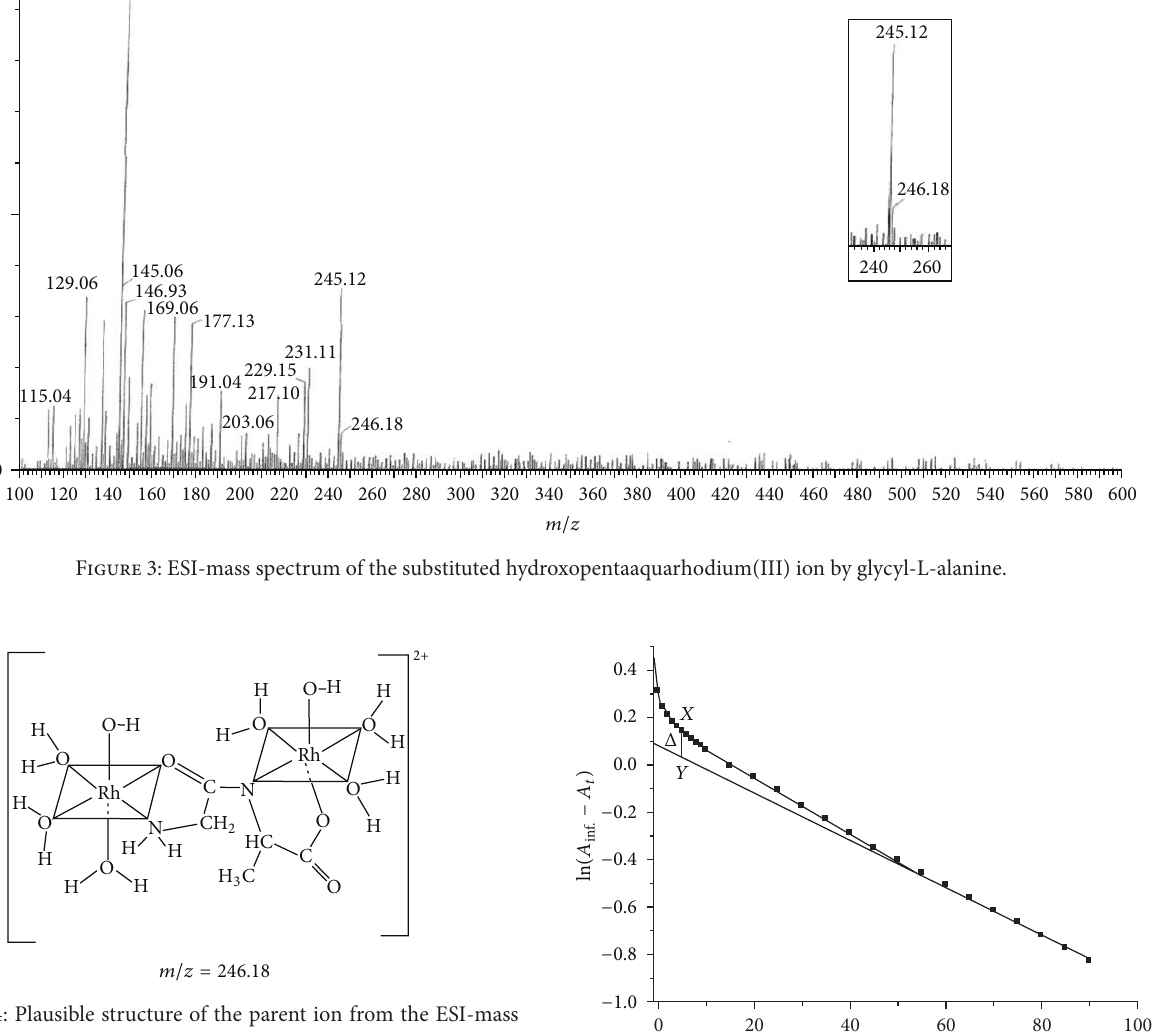
Figure 4: Plausible structure of the parent ion from the ESI-mass spectrum.